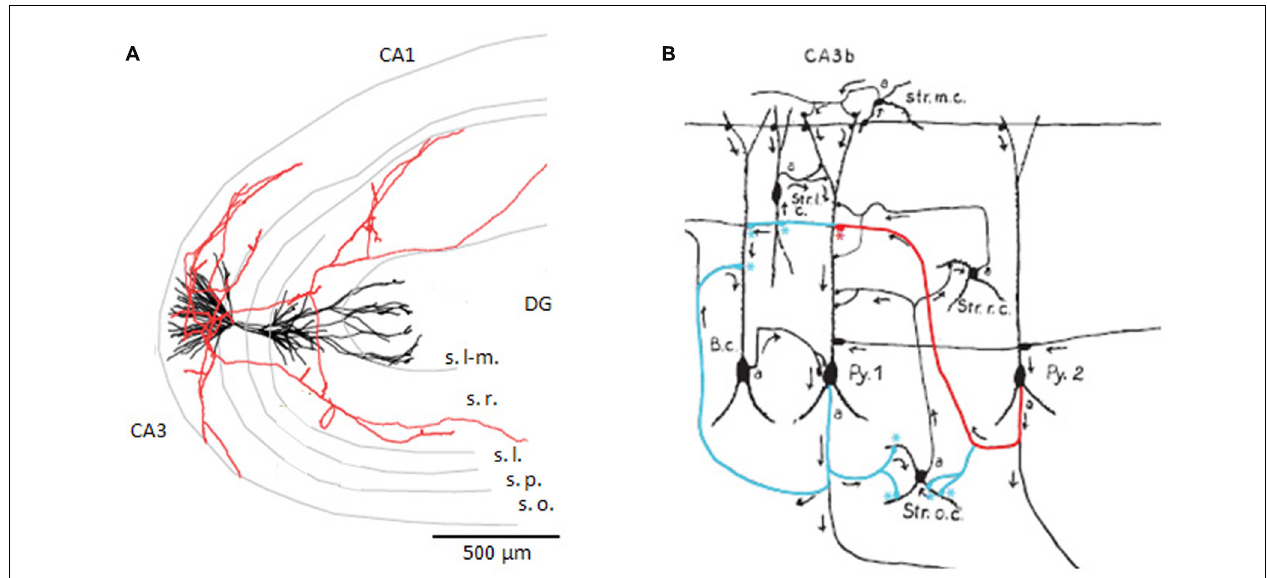
(B) Drawing of putative axo-dendritic connexions between pyramidal cells (Py. 1 and 2) and interneurons with somata in different layers (B.c., Str. o.c., Str. r.c., Str. l.c., Str. m.c.). The axon of Py. 2 may contact the dendrites of Py. 1, in red, and the interneuron of stratum oriens, in blue. The axon of Py. 1 is drawn contacting the basket cell, in blue (drawing adapted from Lorente de Nó,